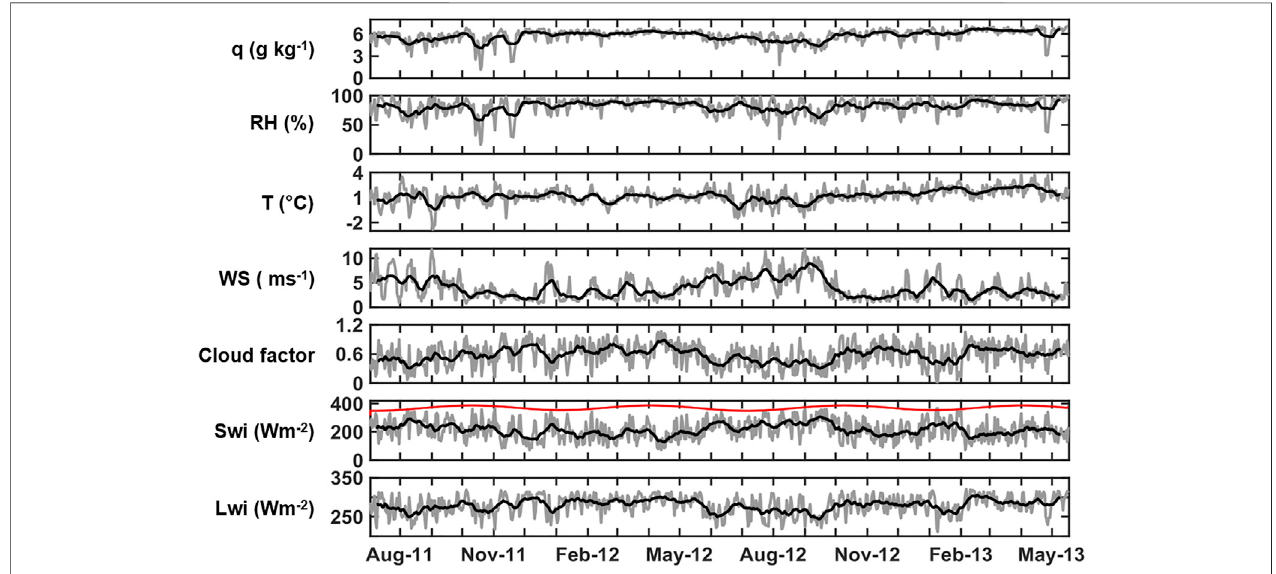
FIGURE3| Summaryofdailymean(grayline)meteorologicalconditionsmeasuredatAWSSAMA-1(4,753 ma.s.l.).Thickblacklinesrepresentthe15-dayrunning means. The red curve shows theoretical solar radiation at the top of atmosphere (STOA) reduced by 50 Wm − 2 and represents maximums theoretical radiation on clear days. The cloud factor CF (dimensionless) was calculated as the ratio between the incoming short-wave radiation and STOA according to Eq. 1 .